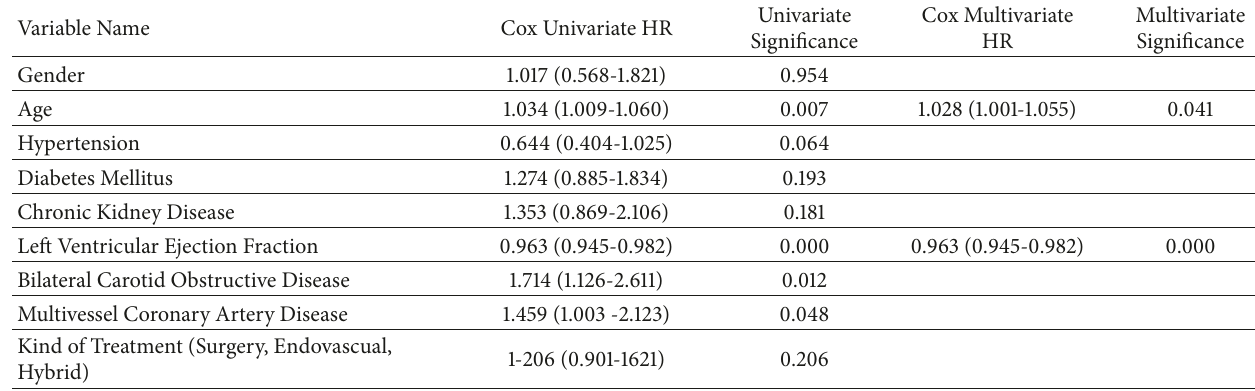
Table 4: Univariate and multivariable Cox regression analysis for the primary end-point.